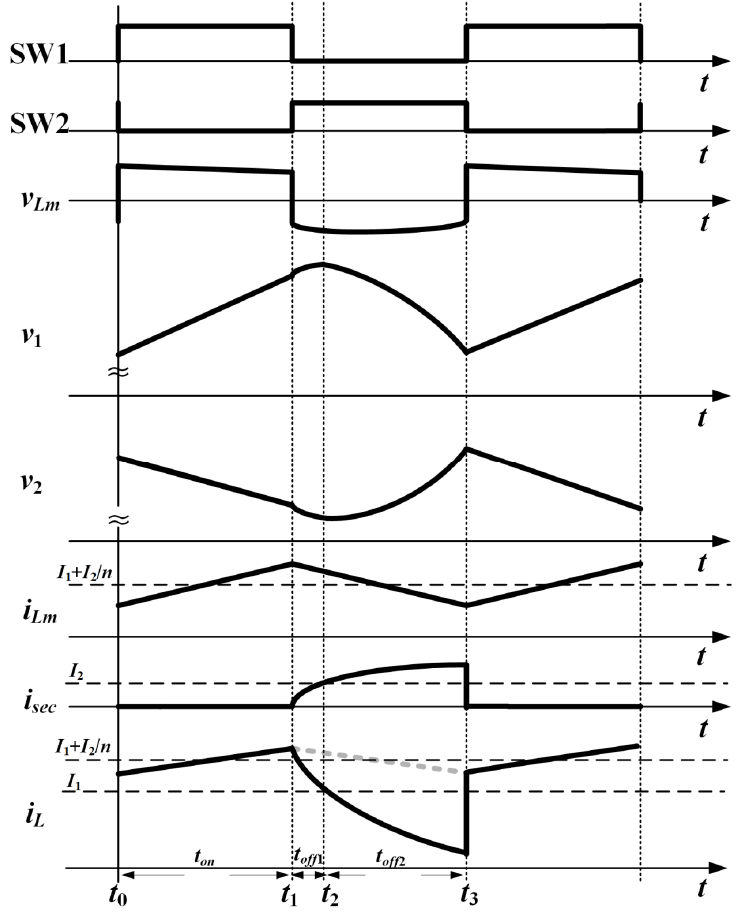
Figure 3. Steady-state waveform of the fly-buck converter.